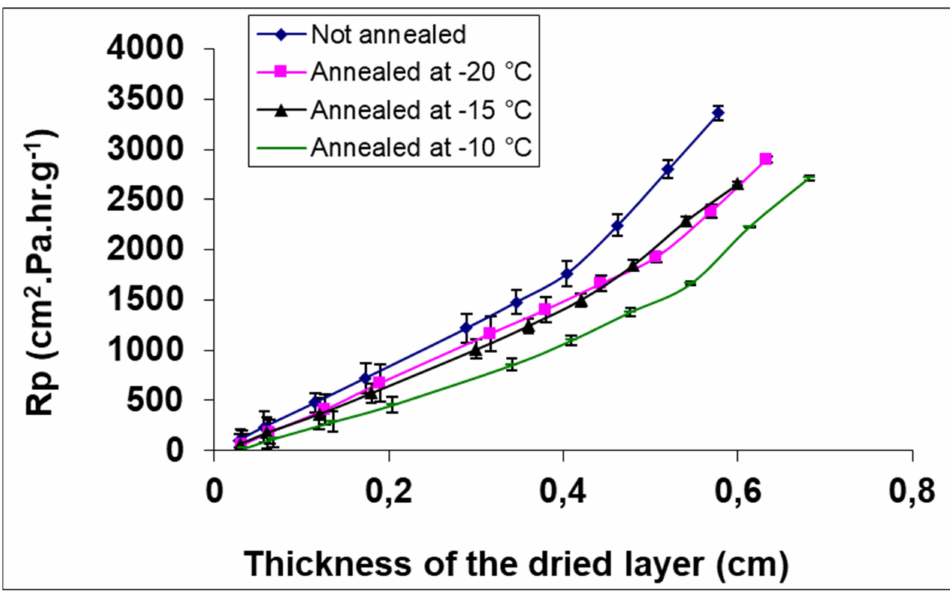
Figure 5. Resistance to mass transfer as a function of freeze-dried layer thickness for formulated PVP at different annealing temperatures. Adapted with permission from ref. [104]. 2021, Springer